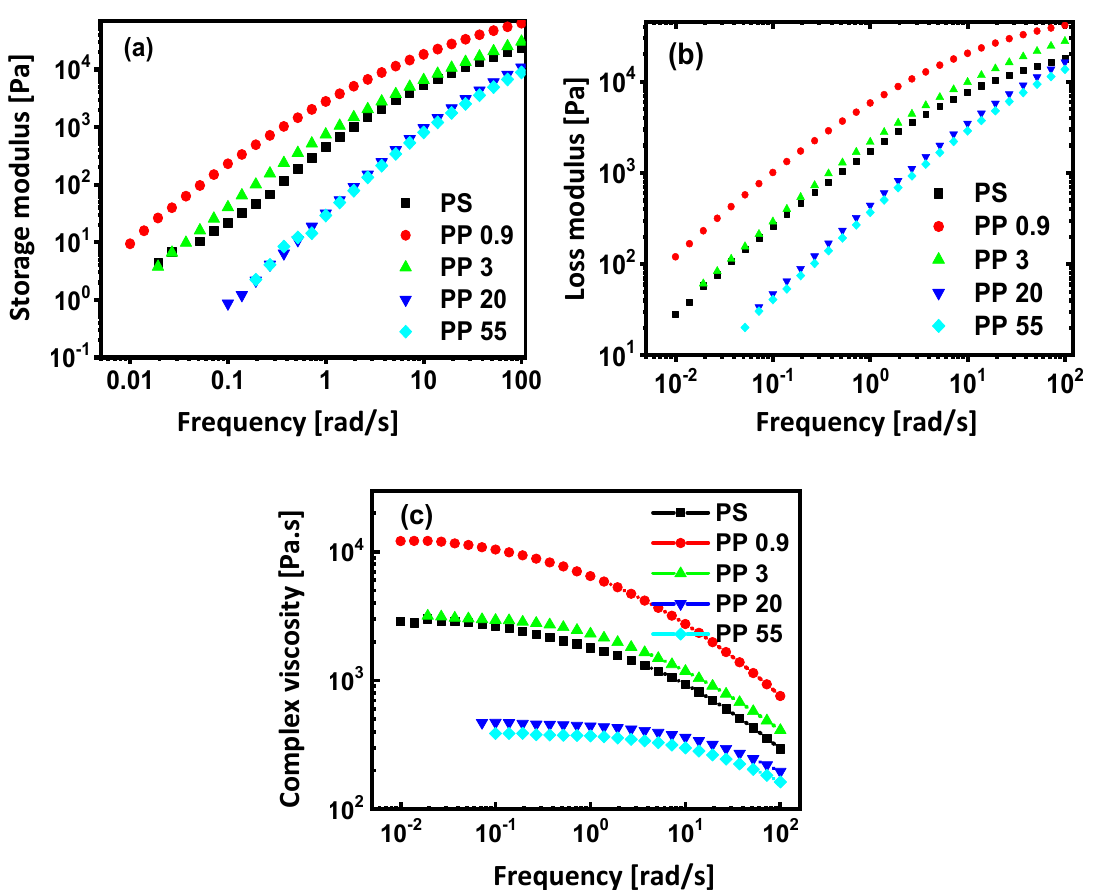
Figure 5. Evolution of ( a ) storage modulus, ( b ) loss modulus, and ( c ) complex viscosity for native polymer melts (PS and PP0.9, PP3, PP20, and PP55) as a function of frequency during oscillatory testing at 200 °C.